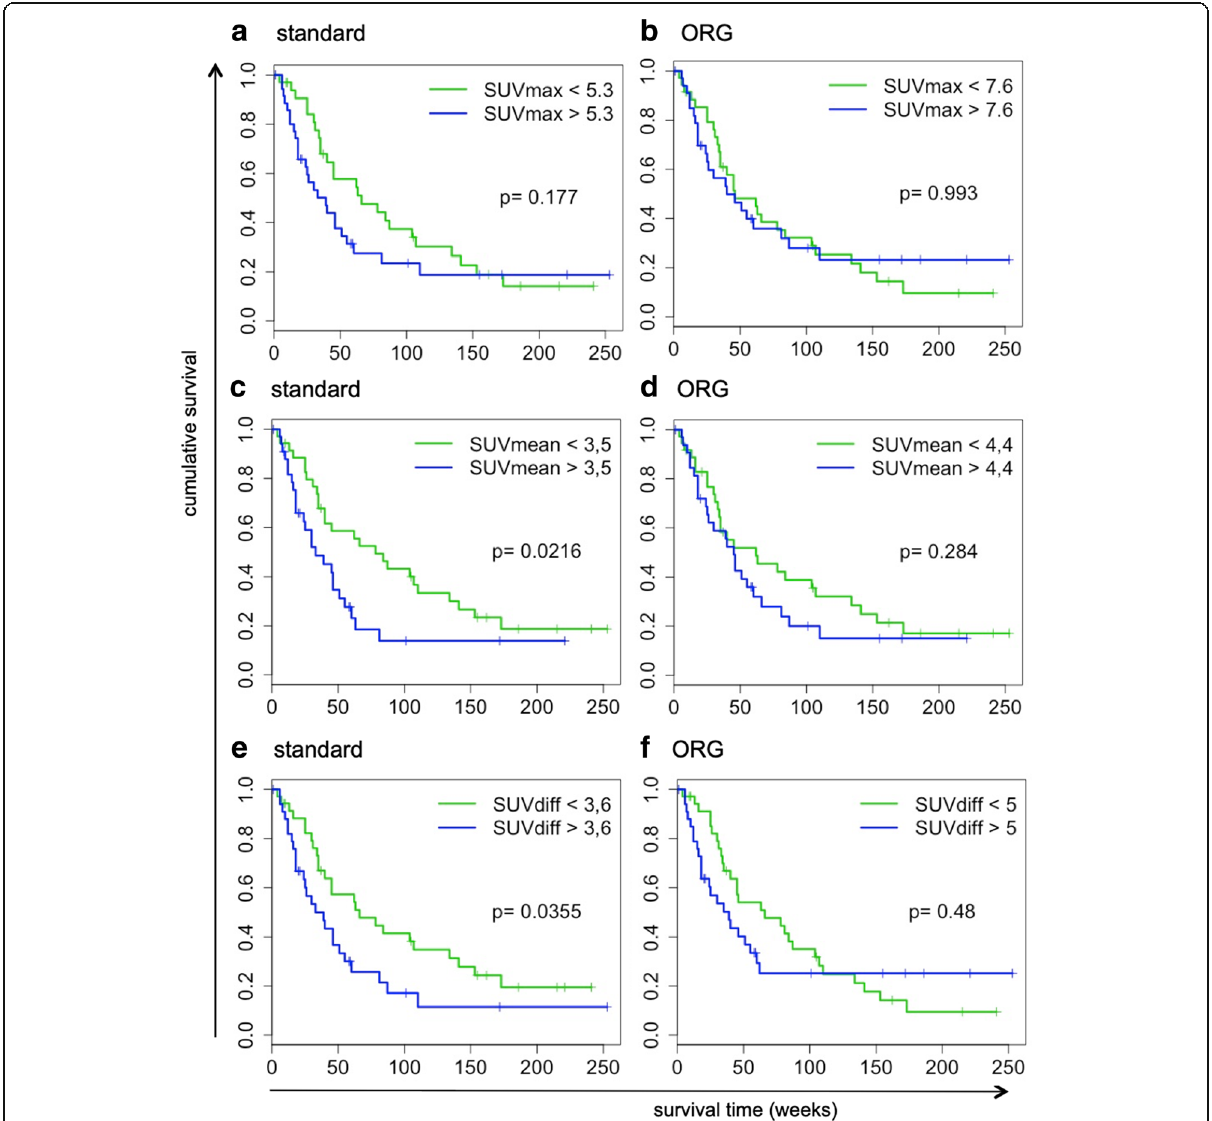
Fig. 4 Optimal respiratory gating impacts the correlation of standard [ 18 F]FDG PET-derived image parameters with overall survival. Kaplan-Meier survival curves demonstrating the impact of compensation of respiratory motion on the correlation of PET-derived parameters with overall survival for standard PET-derived parameters, a – b SUV max , c – d SUV mean , and e – f SUV